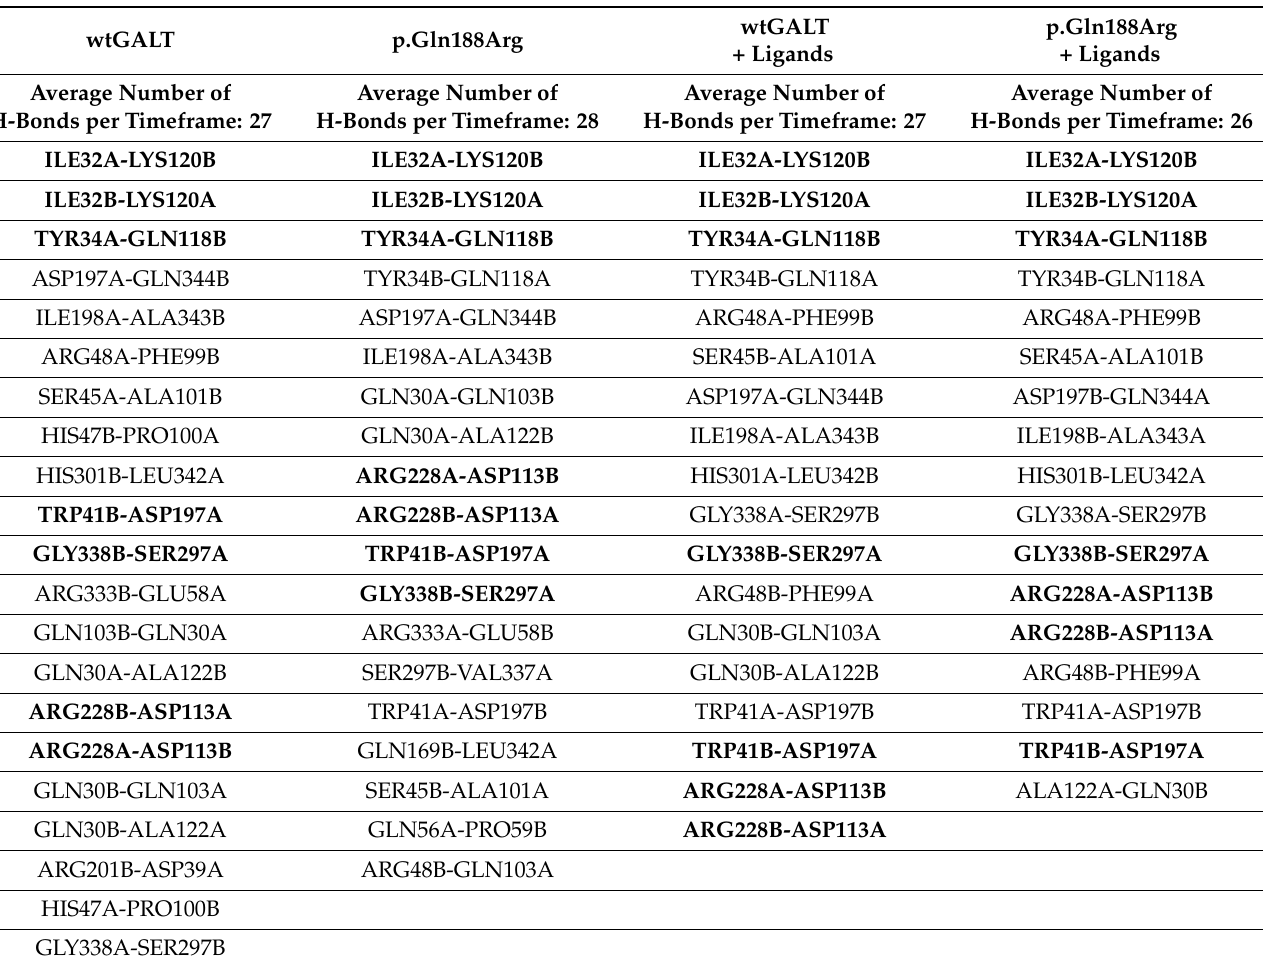
Table 3. Couples of residues involved in stable intersubunit H-bonds in simulations at 334 K. Dark gray background: intersubunit interactions identified in the initial models and conserved throughout the simulations; bold: stable interactions present in all systems. Couples of residues are considered to have a stable H-bond interaction when the sum of % of existence of the H-bonds between the two residues is ≥